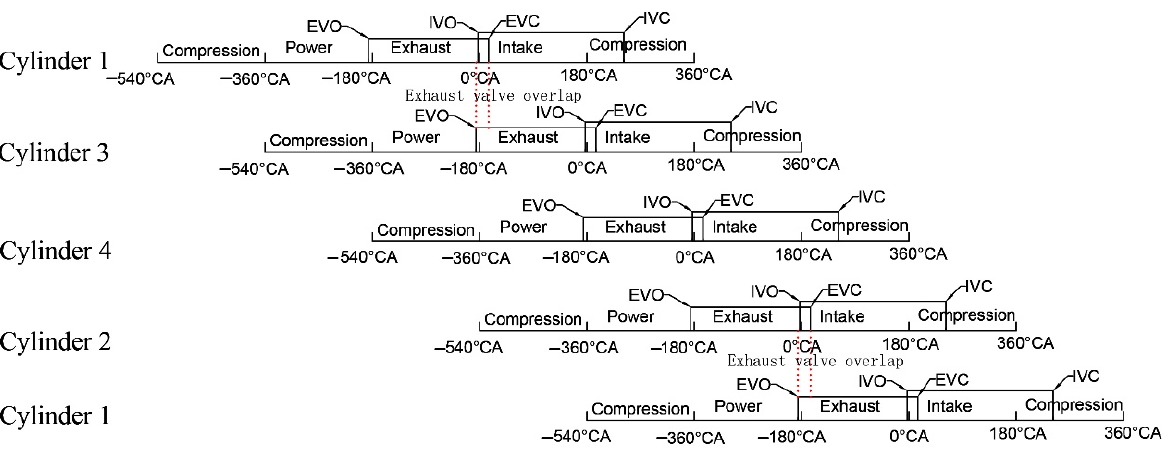
Figure 5. Correspondence between strokes of four cylinders.